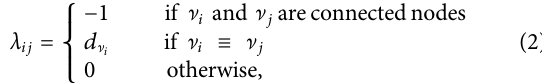
Table 1 . The network so symmetrically displayed is made of three “ columns ” (alternative con fi gurations are given by different schools